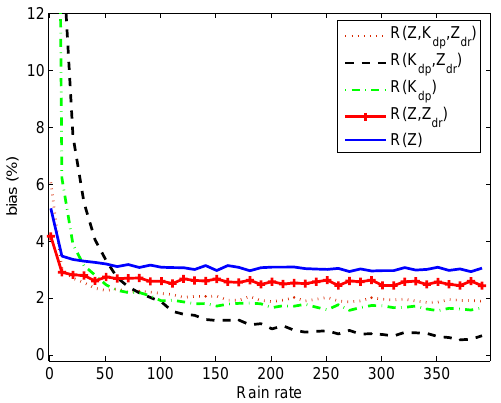
Fig. 6. Rain rates for light to moderate rainfalls over (a) BAO and (b) PLT on 17 June 2004 and, respectively, their corresponding rainfall rate bias (c) for BAO and (d) for PLT.